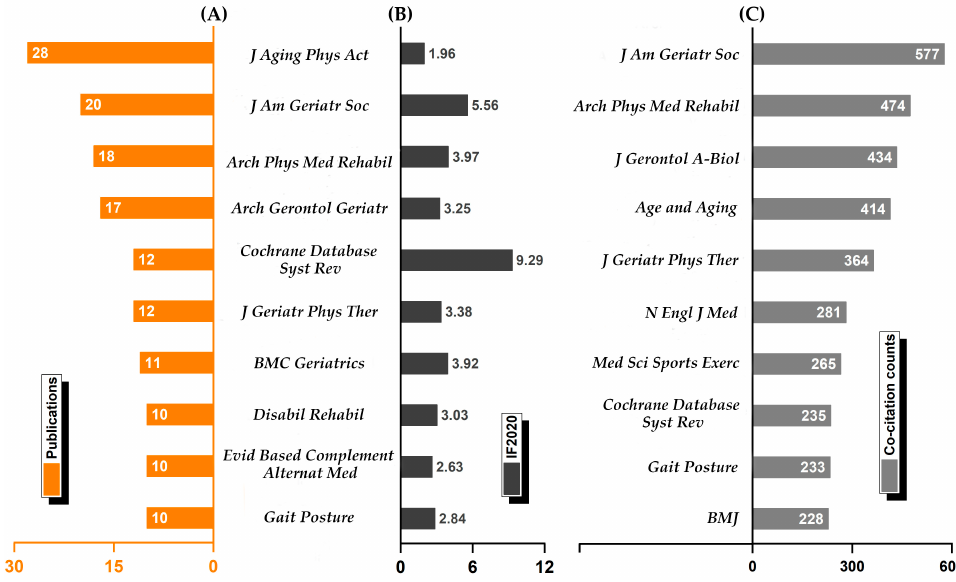
Figure 5. Visualized map of the leading journals. ( A ) Top ten journals by publications; ( B ) top ten journals by impact factor (IF) in 2020; ( C ) top ten co-cited journals based on citation counts. Note: The WoS provided the publications and impact factor (IF), and Citespace provided the citation counts.